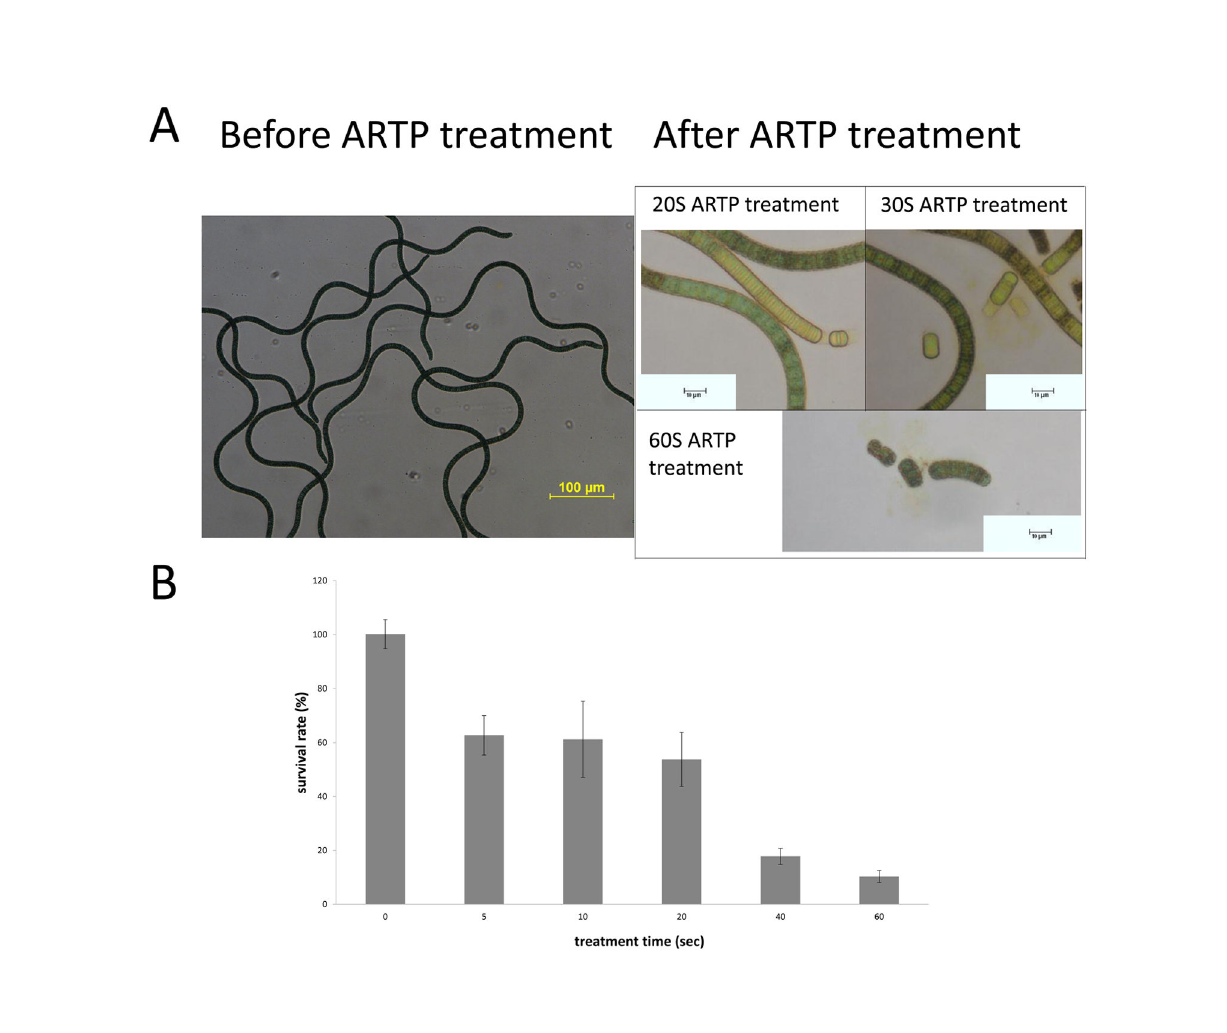
Figure 3. Change of S. platensis after treatment of ARTP. Change of morphology (A) and survival rate (B) of S. platensis during ARTP treatment